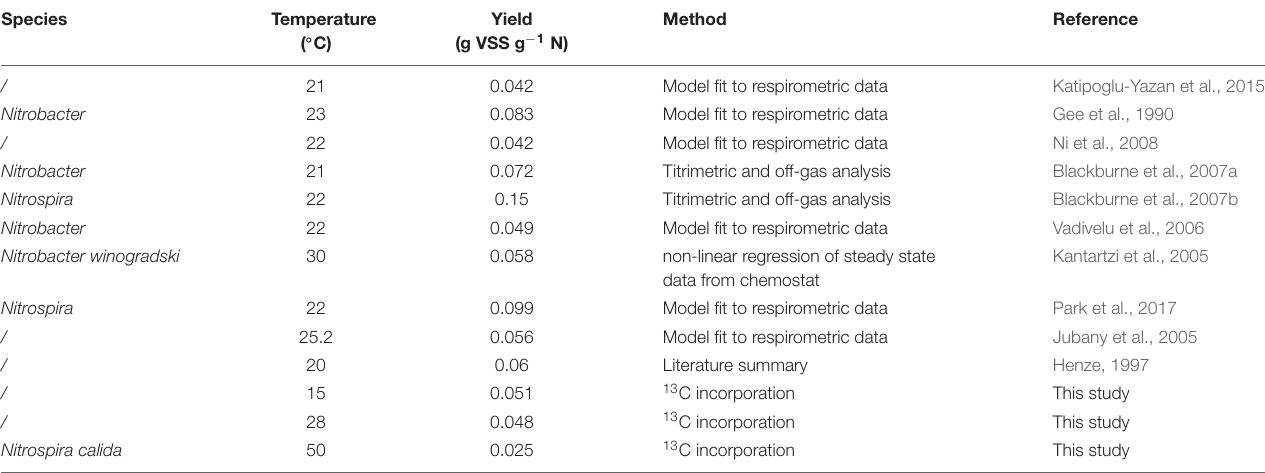
TABLE 3 | Summary of reported maximum yield values of AOB and AOA with the species, imposed temperature and method applied.